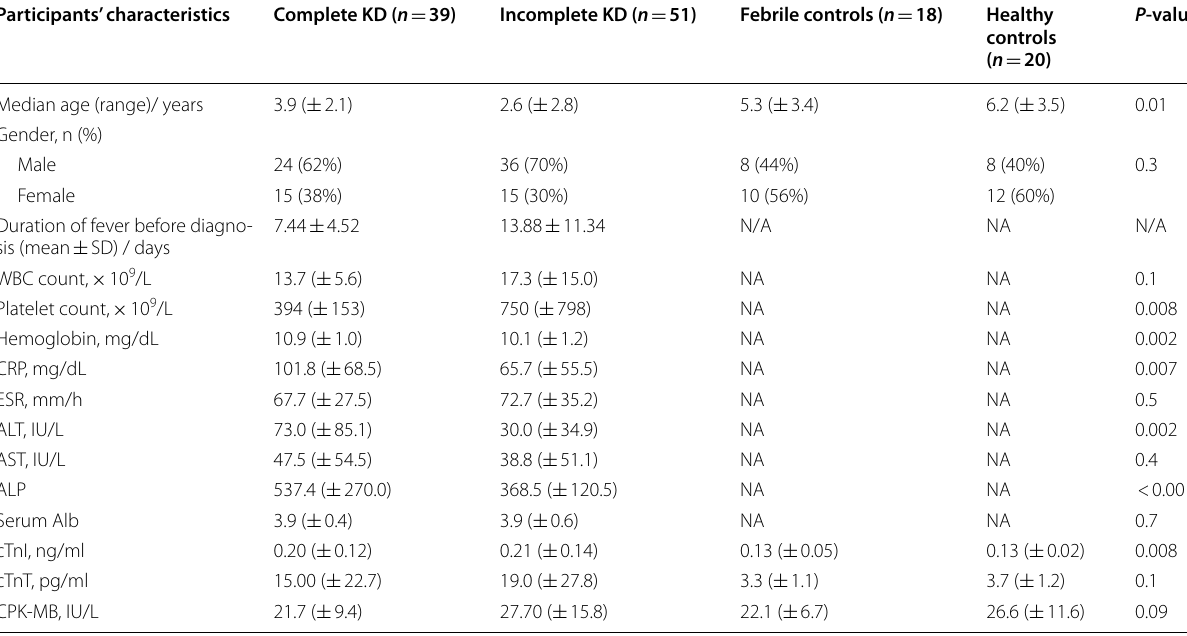
CRP: C-reactive protein; ESR: erythrocyte sedimentation rate; WBC: white blood cell count; ALT: alanine aminotransferase, AST: aspartate aminotransferase; ALP: alkaline phosphatase; Alb: albumin; cTnI: cardiac troponin I; cTnT: cardiac troponin T; CPK-MB: creatine kinase-MB; NA: not